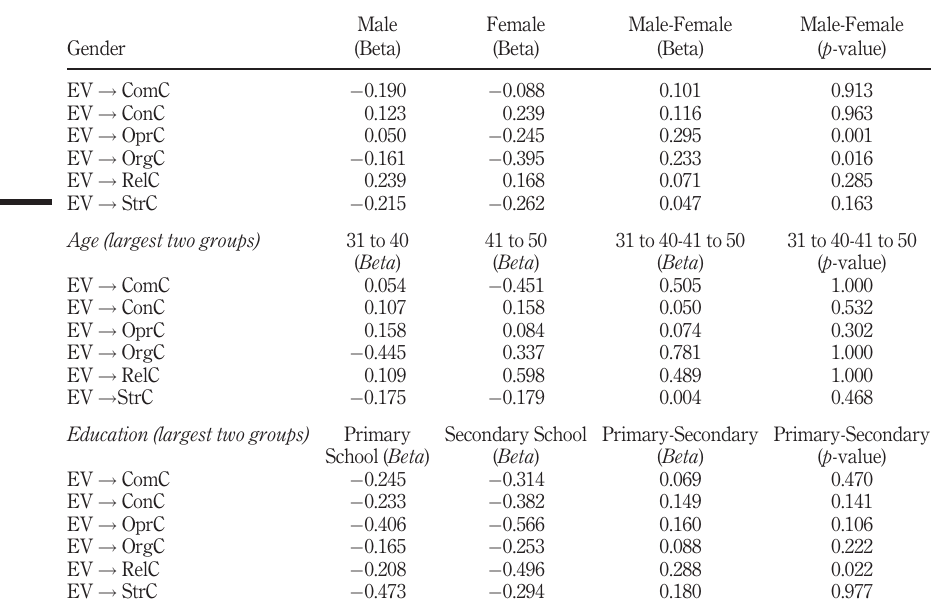
Table V. Multi-group